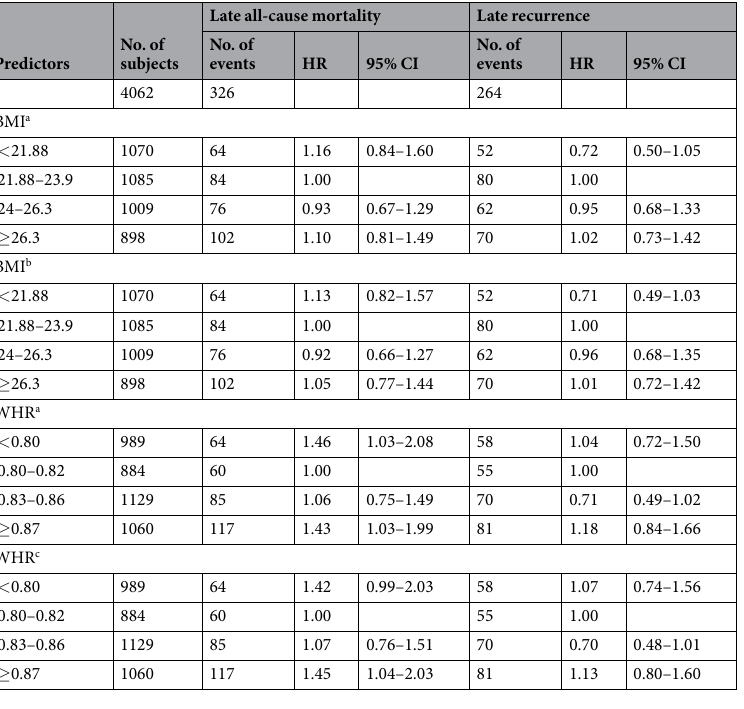
Table 2. Hazard ratios and 95% confidence intervals for post-diagnosis BMI and WHR in association with late all-cause mortality and recurrence of breast cancer, the Shanghai Breast Cancer Survival Study. a Adjusted for age at diagnosis, soy protein intake, regular exercise, ER status, TNM stage, mastectomy, chemotherapy, radiotherapy, comorbidity, education and menopausal status. b Additionally adjusted for WHR ( < 0.80/0.80– 0.82/0.83–0.86/ ≥ 0.87). c additionally adjusted for BMI ( < 21.88/21.88–23.9/24–26.3/ ≥